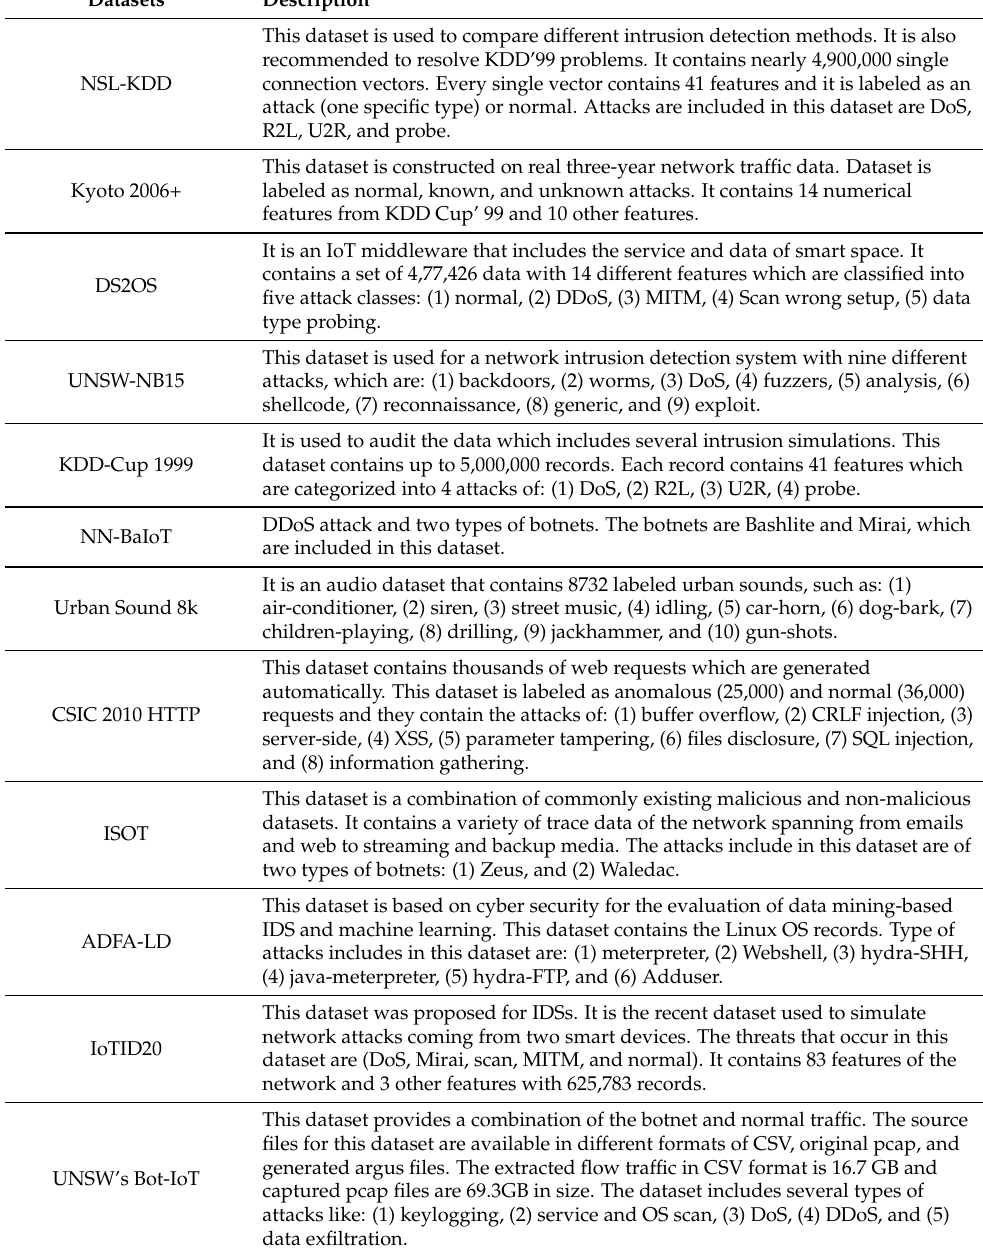
Table 1. Datasets used for detection of malicious attacks in IoT